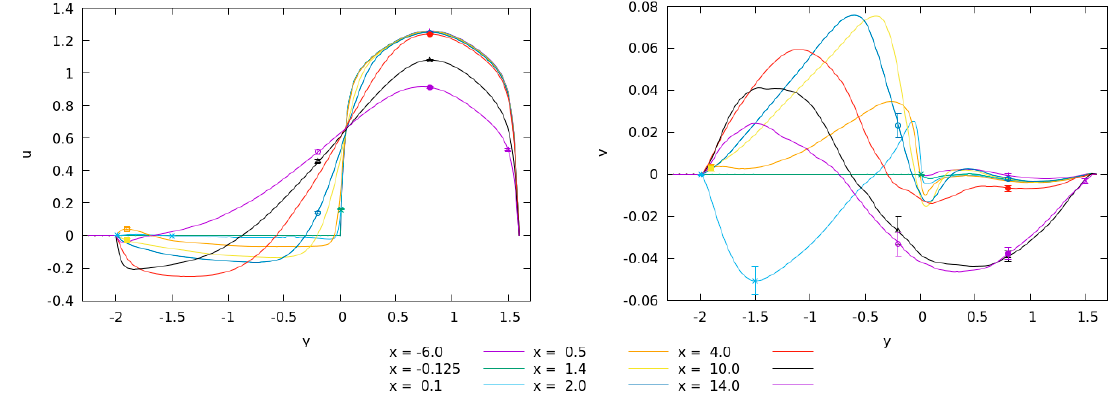
Figure 5. Selected profiles of average velocity components through the midplane ( z = 0) at positions where monitor points are present together with the 2 σ uncertainty in these points.